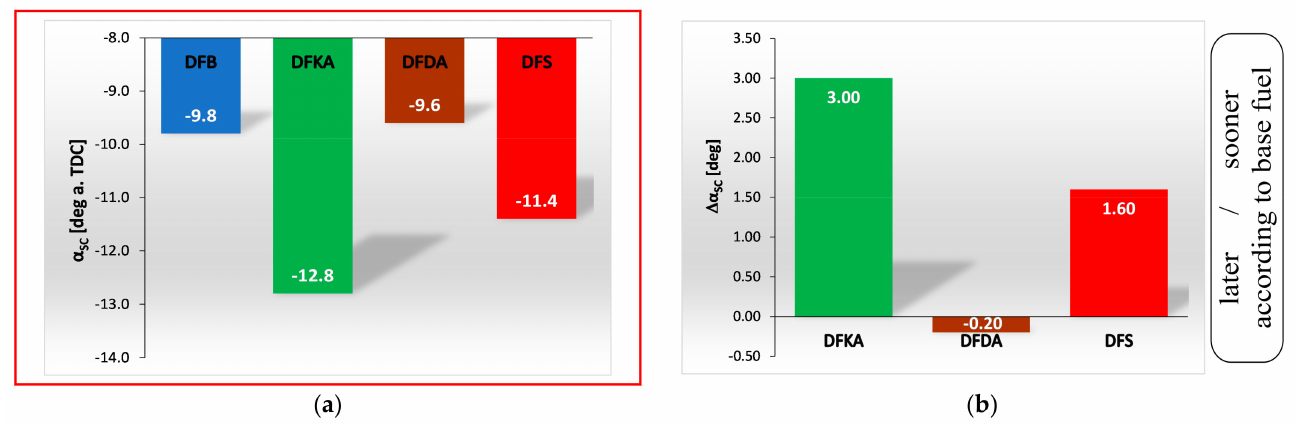
Figure 14. ( a ) Start of fuel self-ignition ( α SC ) for tested fuels. ( b ) Percent change in start of fuel self-ignition ( ∆ α SC ) for tested fuels relative to α SC for DFB.